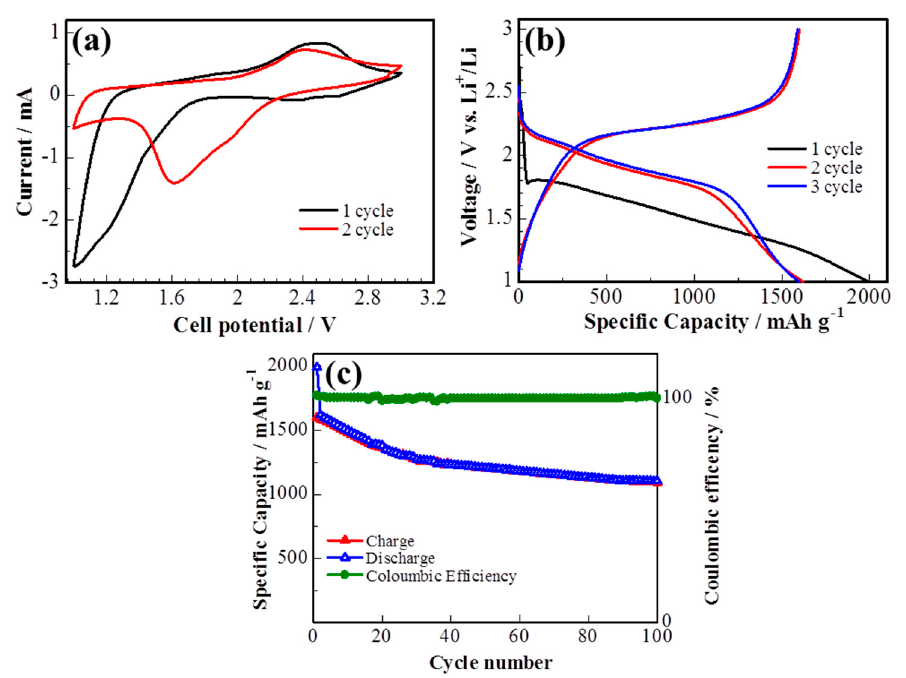
Figure 5. ( a ) Cyclic voltammetry (CV) curve, ( b ) potential profile and ( c ) cycle performance of the sulfur composite on cPAN CNFs at 0.1 C.